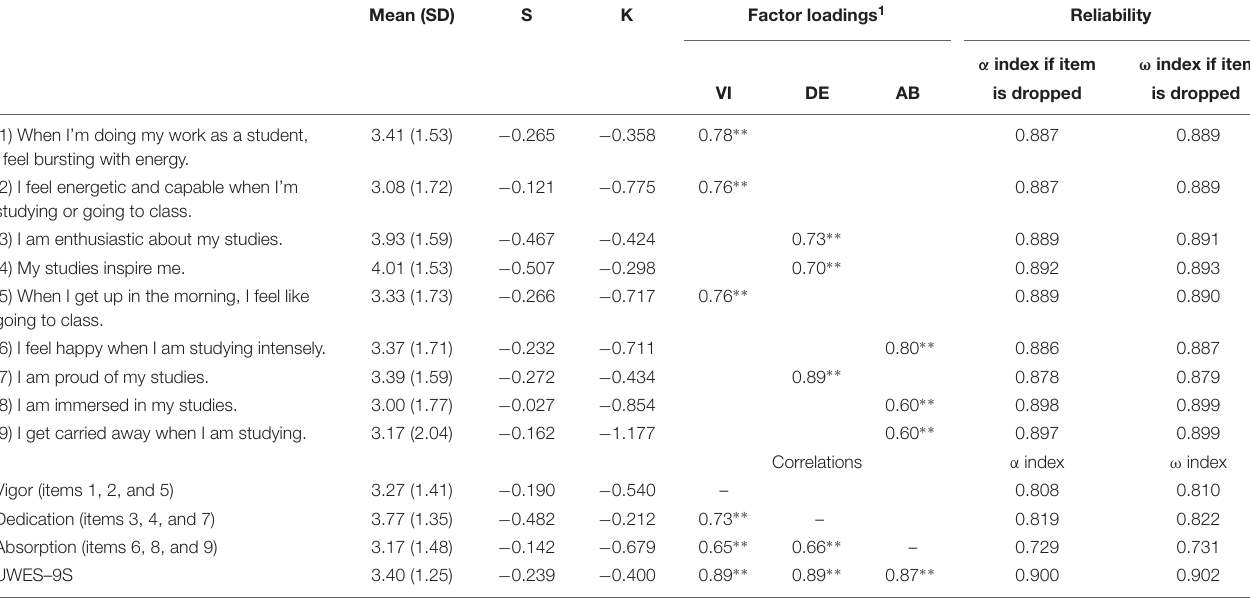
TABLE 1 | Descriptive information of the UWES–9S and factor loadings resulting from CFA.